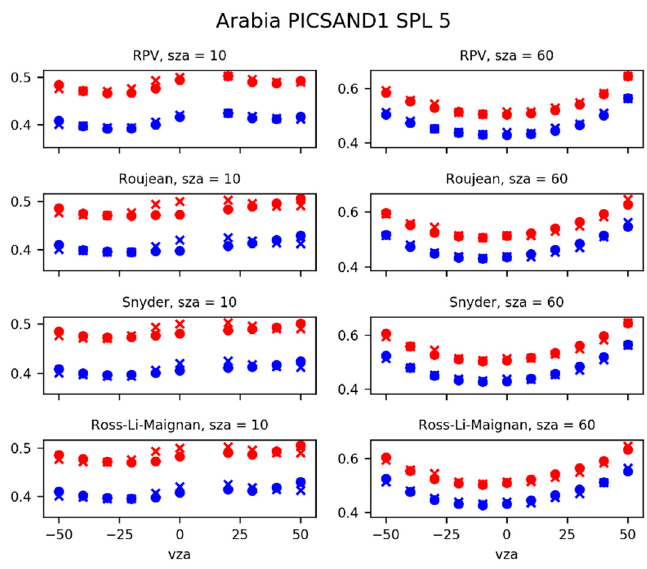
Figure 17. Arabia_PICSAND1_SPL5 measured (cross) and modeled (dot) BCRF for SZA = 10 and VZA = 60°, wavelength = 670 (in blue) and 875 nm (in red).